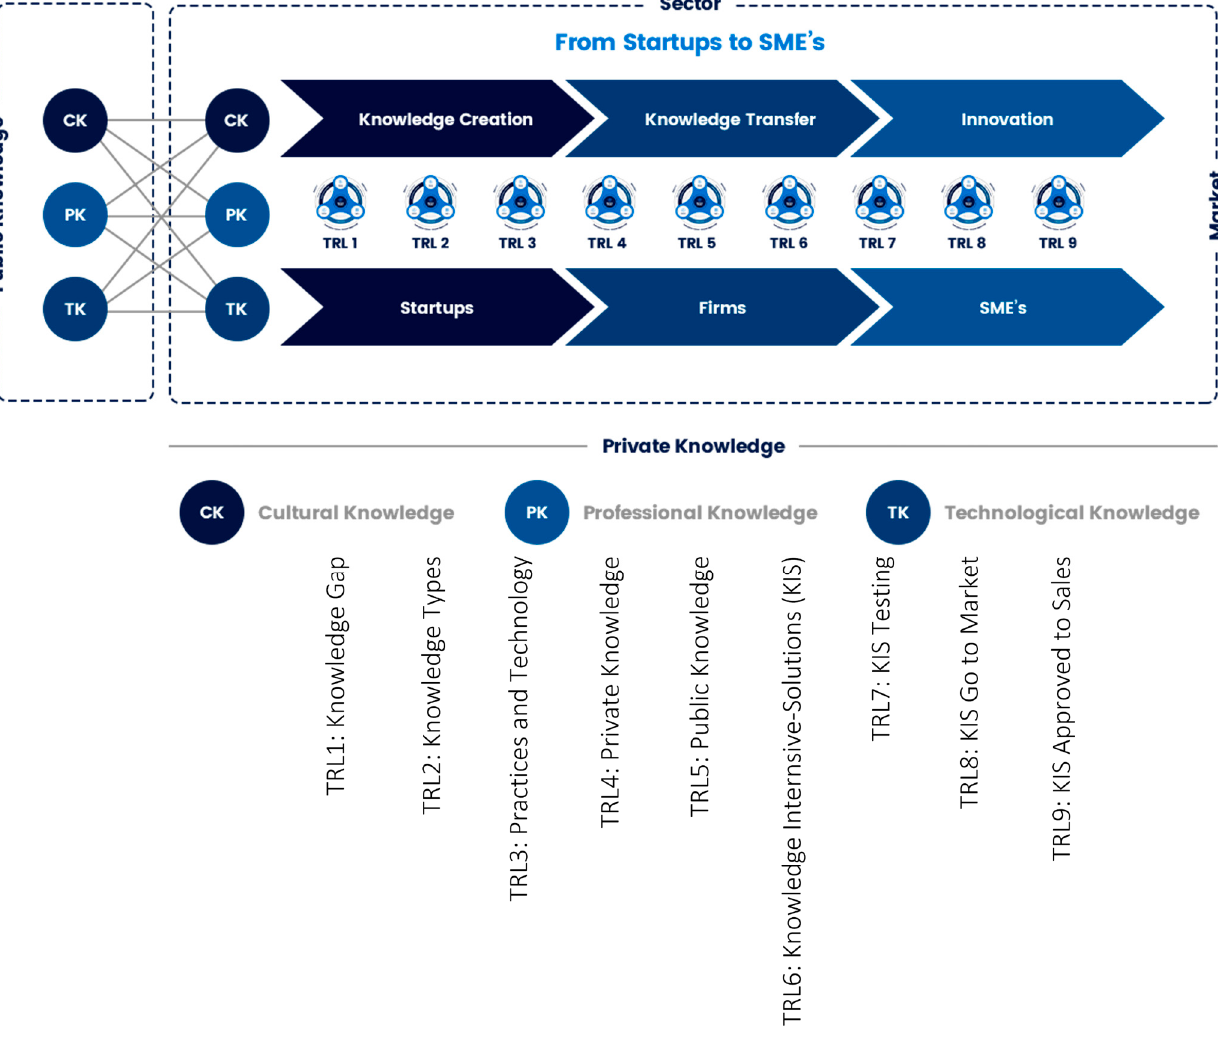
Figure 3. The Spinner Knowledge Flow in Support of Triple Helix Model Interactions .